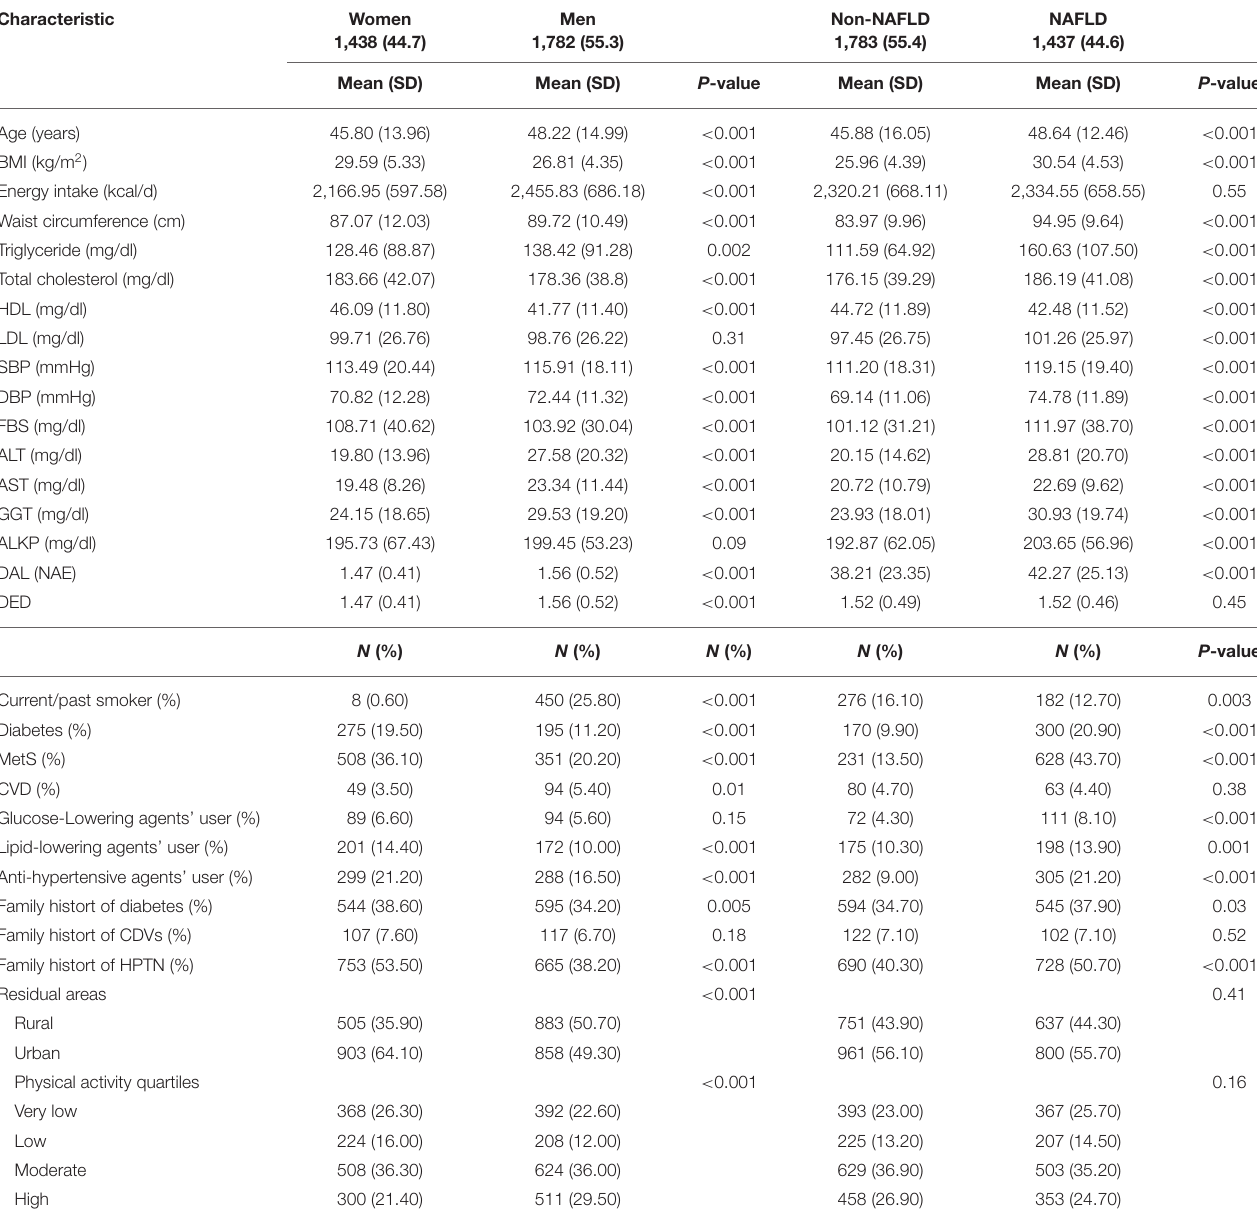
TABLE 3 | Characteristics of the study participants: adults ( n = 3,149, aged ≥ 18 years) at baseline, Amol Cohort Study, Iran, 2016–2017.